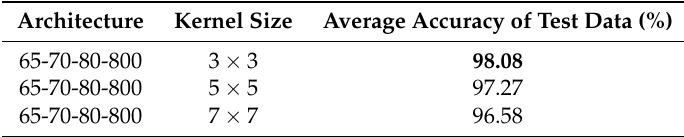
Table 2. The recognition accuracy comparison for kernel sizes. The boldface entries represent the highest accuracy.